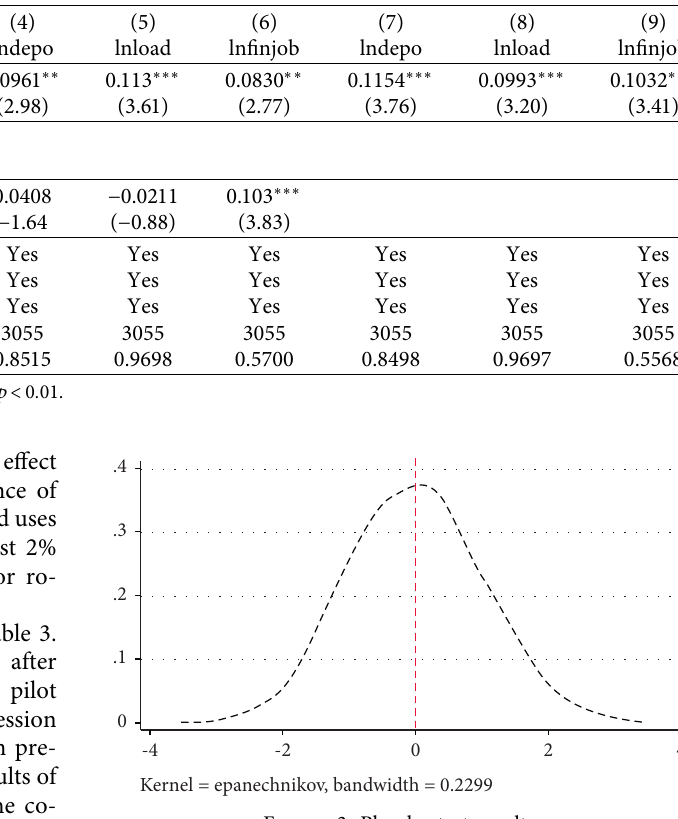
Figure 3: Placebo test